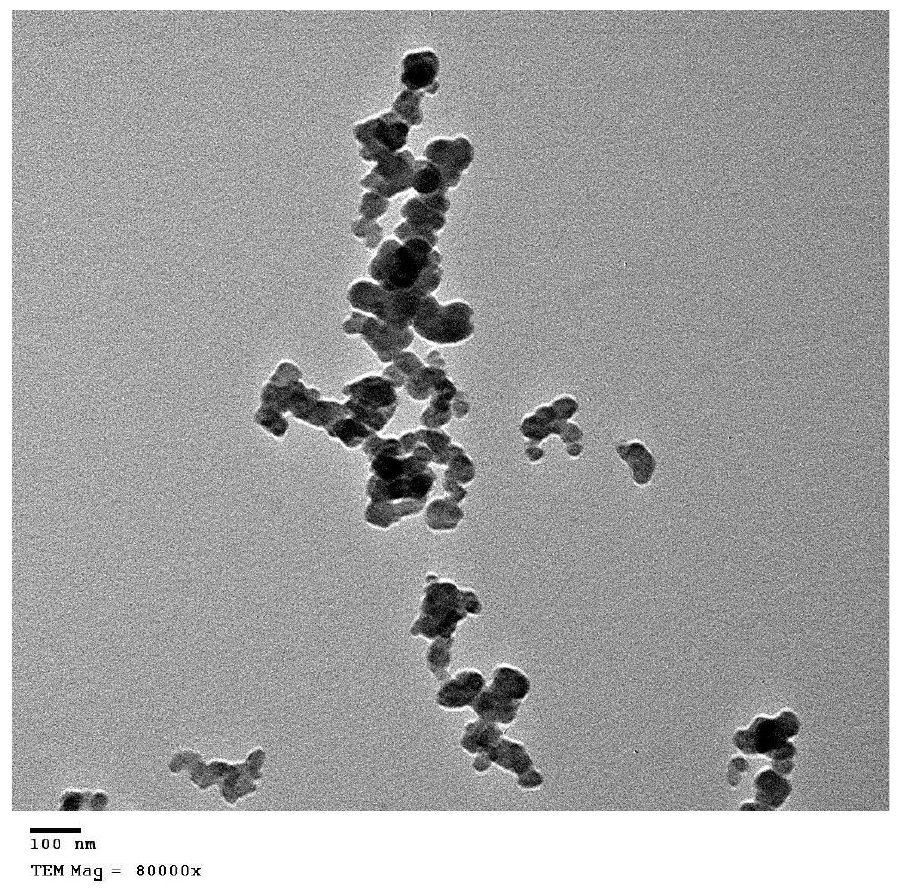
Separations 2023 , 10 , x FOR PEER REVIEW